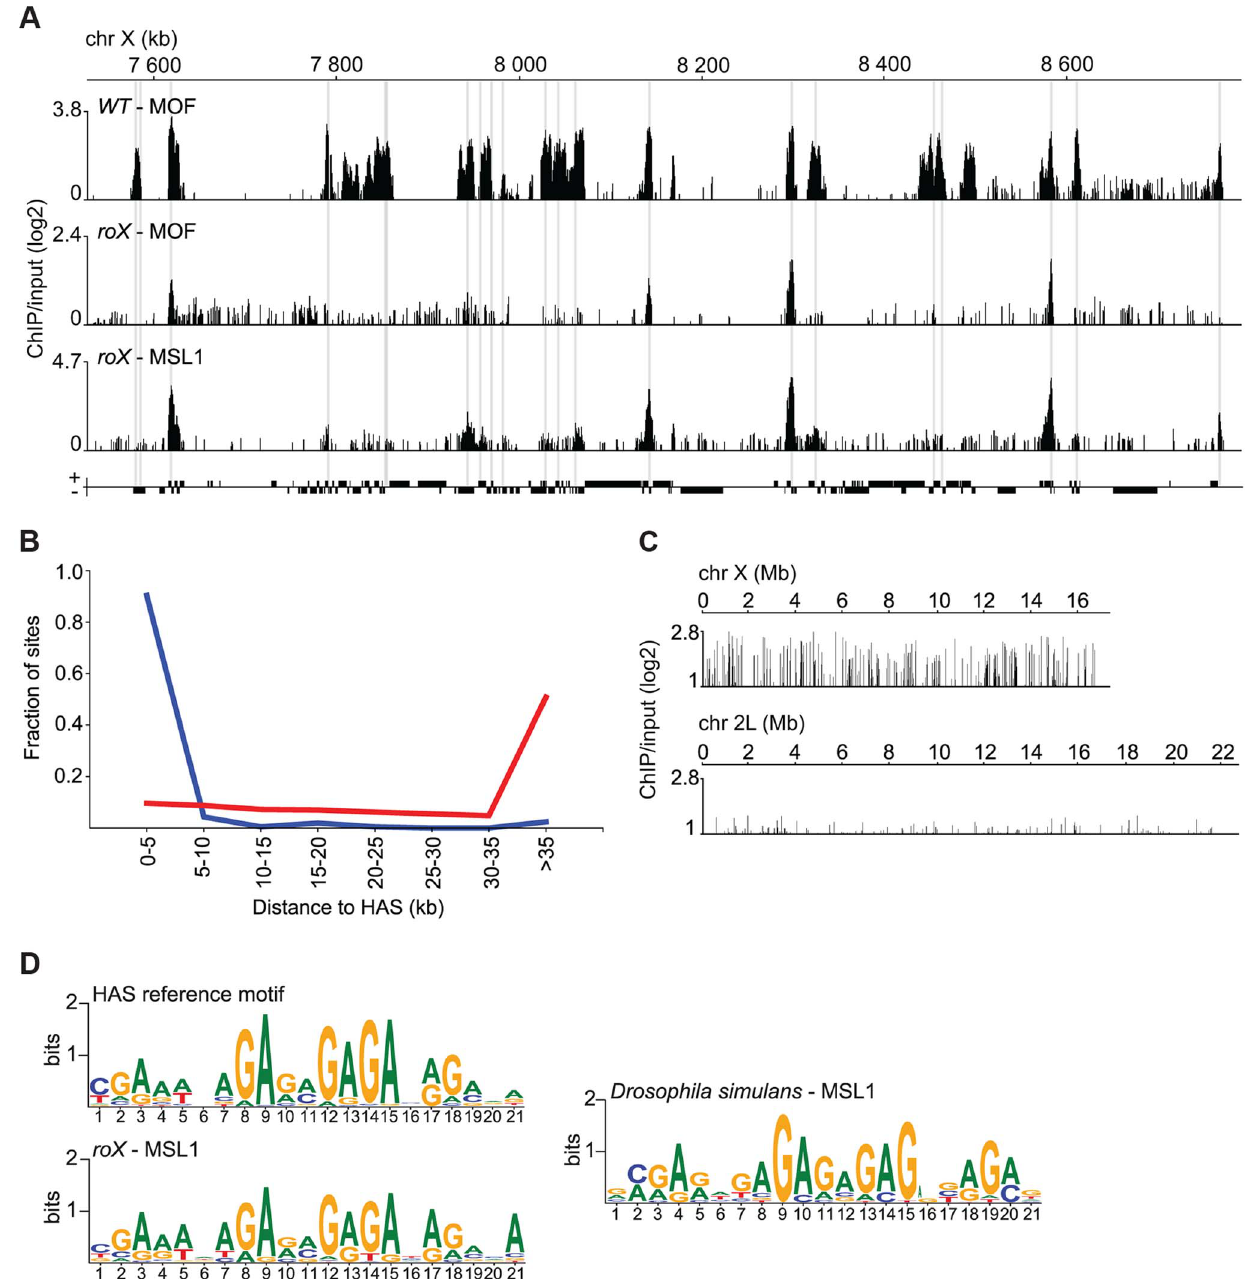
Fig. 2. MSL recruitment to the conserved HAS is independent of roX. (A) MOF and MSL1 ChIP-seq enrichment profiles, with a 500 bp smoothing, for a representative region of the X-chromosome in salivary gland tissue from wild type and roX mutant males. Numbers along the x-axis denote positions along the chromosome in kb. The y-axis shows the ChIP enrichment over input as log2 ratios. Genes expressed from left to right and vice versa are shown above and below the horizontal lines, respectively. The HAS locations, previously defined by [34,37,38], are indicated by grey boxes. (B) Fraction of sites on the X-chromosome from roX mutants that are bound by MSL1, compared to random sites along the X-chromosome (red), sorted by distance to HAS. (C) MSL1 ChIP-seq enrichment profile, with a 500 bp smoothing, for the entirety of chromosomes X and 2L in salivary glands from D. simulans wild type males. Numbers along the x-axis denote chromosomal positions in Mb. The y-axis shows the ChIP enrichment over input as log2 ratios. (D) Sequence motifs enriched in MSL-bound regions of the X-chromosome in D. melanogaster wild type [37], roX mutants and D. simulans wild type.